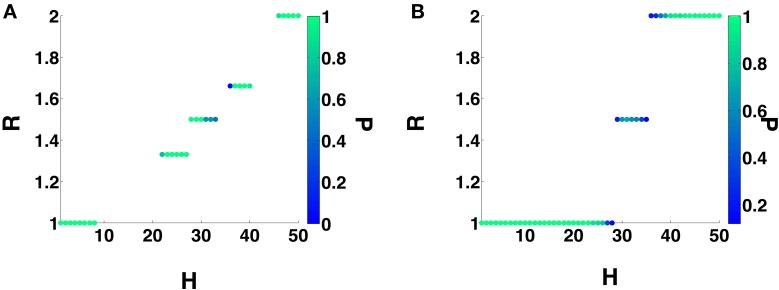
2-MCI Synchronization Ratio probability for η0 = 0. (A) Shows the probability of the 2-MCI network to reach different orders of synchronization without STDP. (B) Shows the probability for different orders of synchronization with STDP. The range of H for which the network can synchronize is significantly enhanced for the 1:1 domain and higher orders.